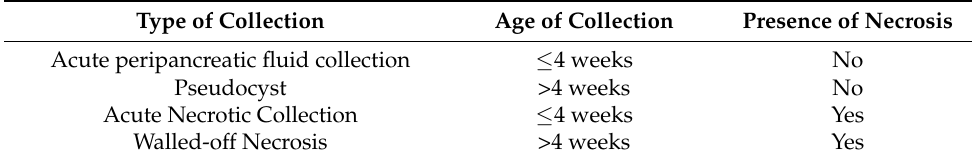
Table 1. The 2012 Atlanta classification system of pancreatic fluid collections (PFCs) [6]. Type of Collection Age of Collection Presence of Necrosis Acute peripancreatic fluid